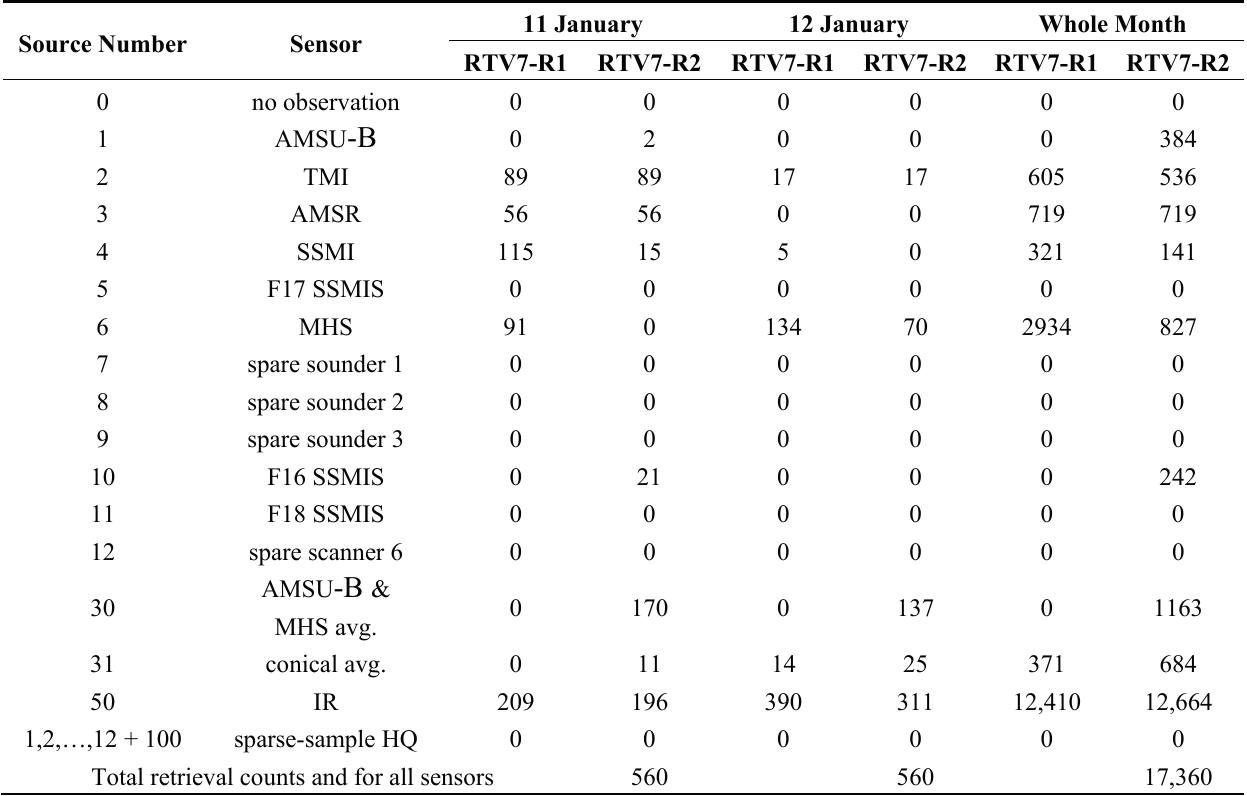
Table 5. Retrieval counts of sensors introduced into the TMPA processing for all grids over the Jinghe river basin on 11 January, 12 January, and the whole January in 2008,